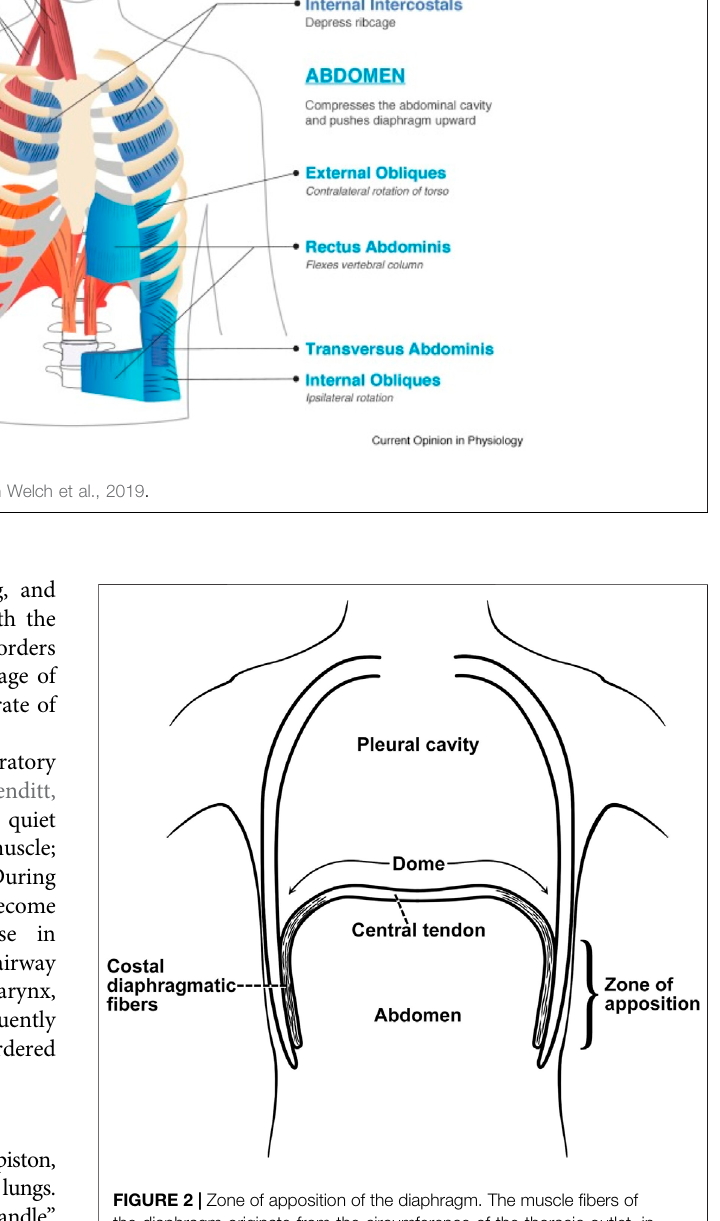
Frontiers in Physiology |